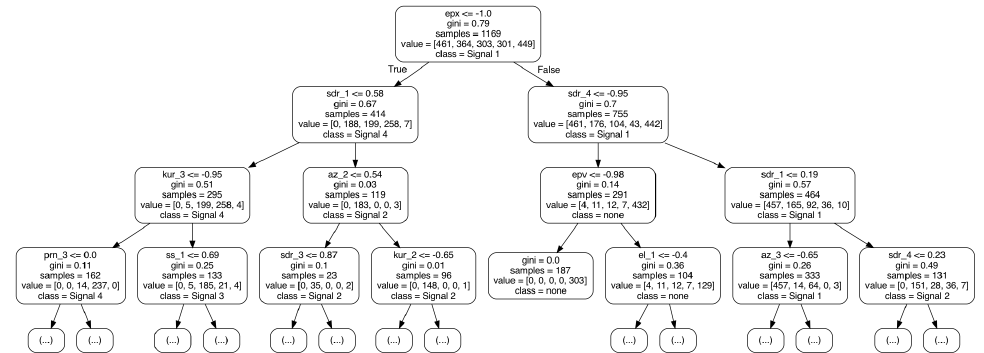
Figure 13. Example tree of a trained RF model. Dependent on the properties of the current features, the RF model (at each block) makes a decision that is true (left arrow) or false (right arrow) until the leaf of the RF model is reached and a decision for classification is